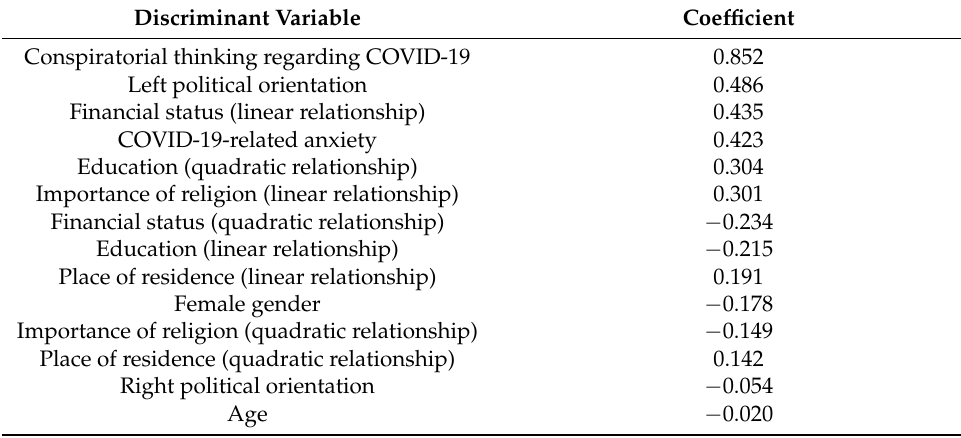
Table 2. Coefficients of the first discriminant